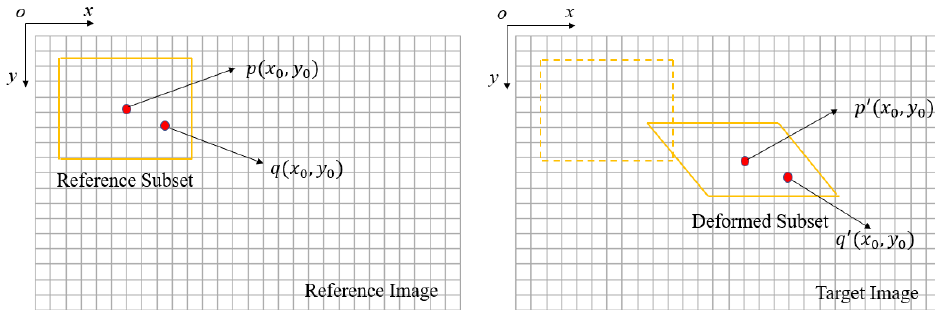
Figure 2. Basic principle of digital image correlation.